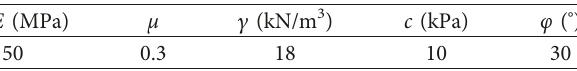
embankment surface; 2 (cid:31) embankment shoulder). (cid:31)